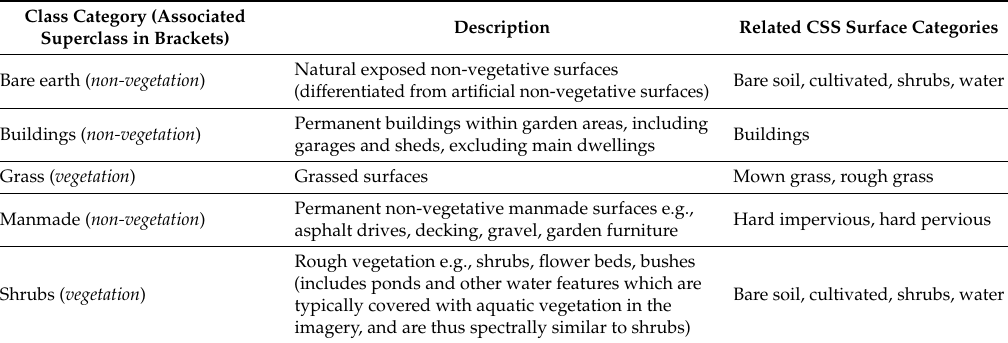
Table 2. Image classification